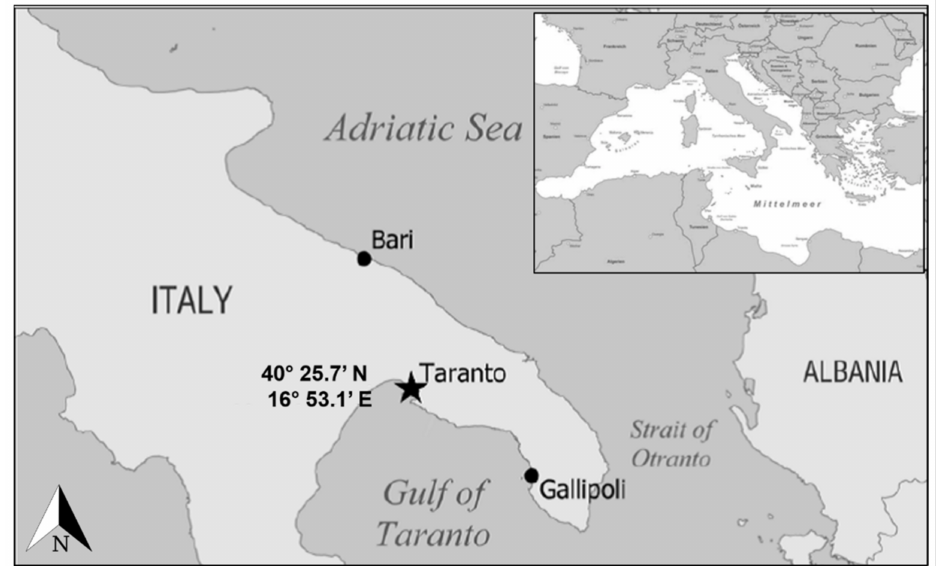
Figure 1. Map of the sampling location indicated with a star (Ginosa Marina, Gulf of Taranto, Ionian Sea) in the Mediterranean